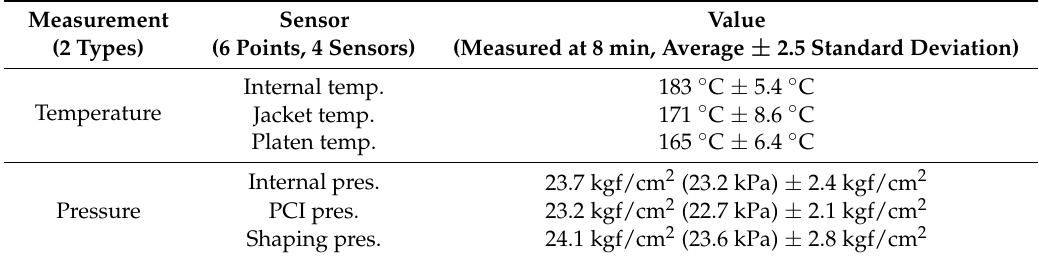
Table 3. Values measured using vulcanizer